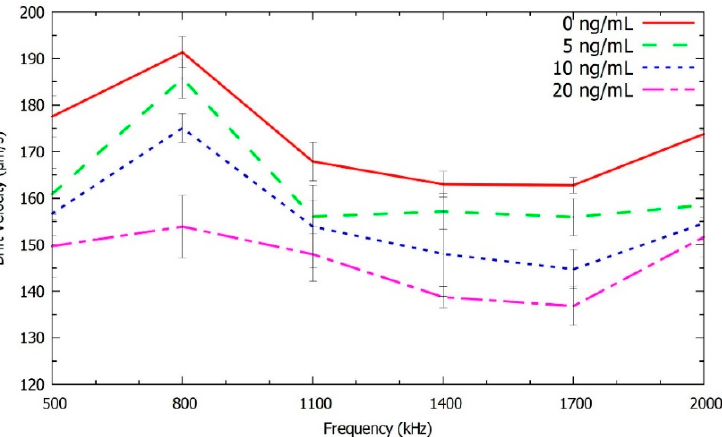
Figure 5. Negative DEP spectrum for the various concentration levels of CEA at 5 ng/mL, 10 ng/mL, 20 ng/mL, and 0 ng/mL. The 0 ng/mL was a control sample without the native antigen of CEA in the sample to bind to CEA antibody functionalized PMs. The results shown in each frequency per curve are the mean of six measurements, and the error bars show their respective confidence inter- vals.